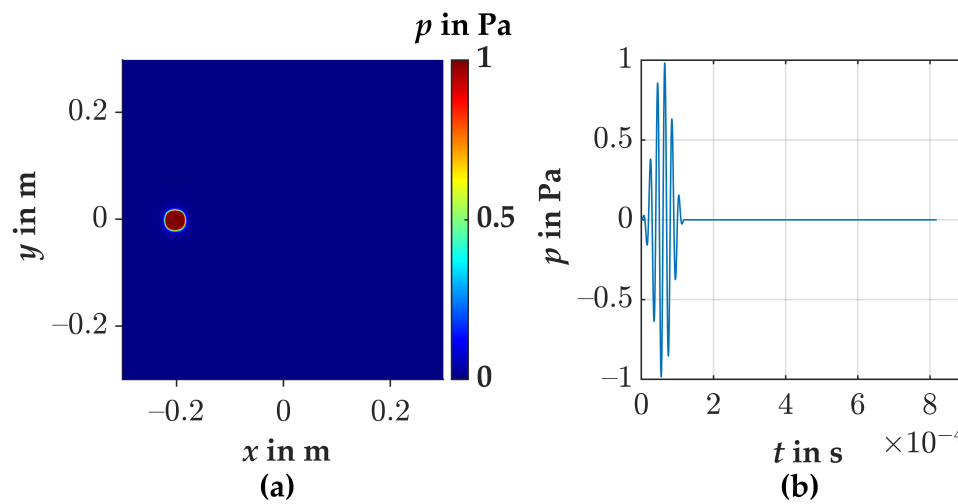
Figure 6. ( a ) Sound pressure amplitude of the tilted academic piston transducer in the plane z = 0 m; ( b ) transient pressure signal of the academic piston